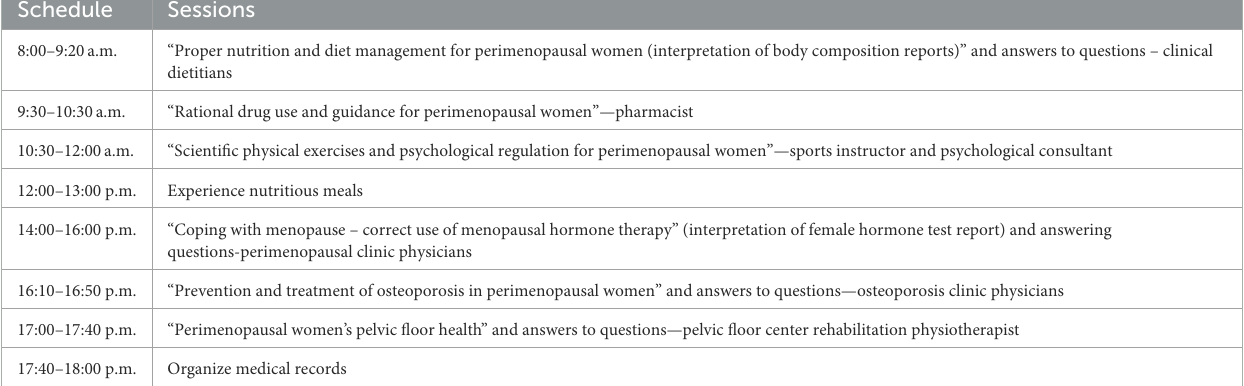
TABLE 2 The 1 day of multidisciplinary health education sessions